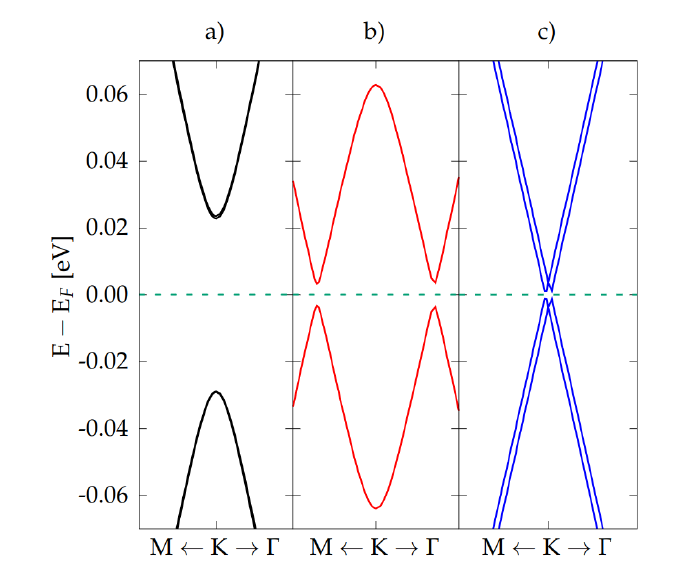
Figure 2. Band structure of the quadrilayers C-BN-BN-C in ( a ) non twisted AB-AA (cid:48) -AB, ( b ) non twisted √ 7 cell. AB-AA (cid:48) -AB (cid:48) , and ( c ) twisted T-AA (cid:48) -T configuration. All bands are calculated in a √ 7 × Table 3. Fermi velocities and electron-hole effective masses for the C-BN-BN-C quadrilayers. v System